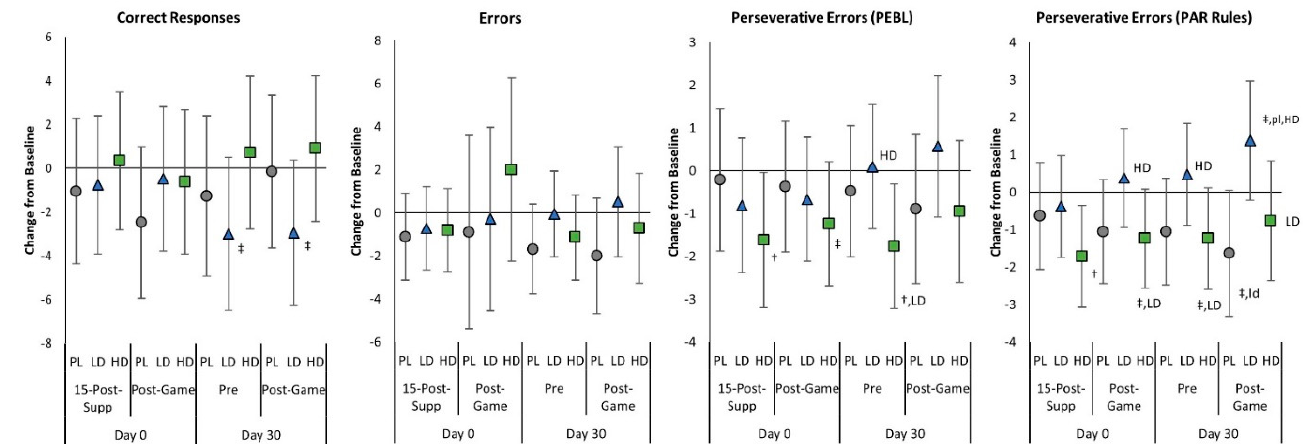
Figure 4. Berg-Wisconsin Card Sorting Test mean changes with 95% con fi dence intervals from Day 0, pre-game (Pre) values for the placebo (PL), low-dose (LD), and high-dose (HD) groups. † represents p < 0.05 from Pre values while ‡ represents p > 0.05 to p < 0.10 e ff ect. 15-min-Post-Supp represents data obtained 15 min after supplementation, and Post-Game represents data obtained after competitively playing video games for 60 min. Group di ff erences ( p < 0.05) are shown as di ff erences from placebo (pl), low-dose (ld), and high-dose (hd) groups, while statistical tendencies ( p > 0.05 to p < 0.10) are shown in large cases (PL, LD, HD)